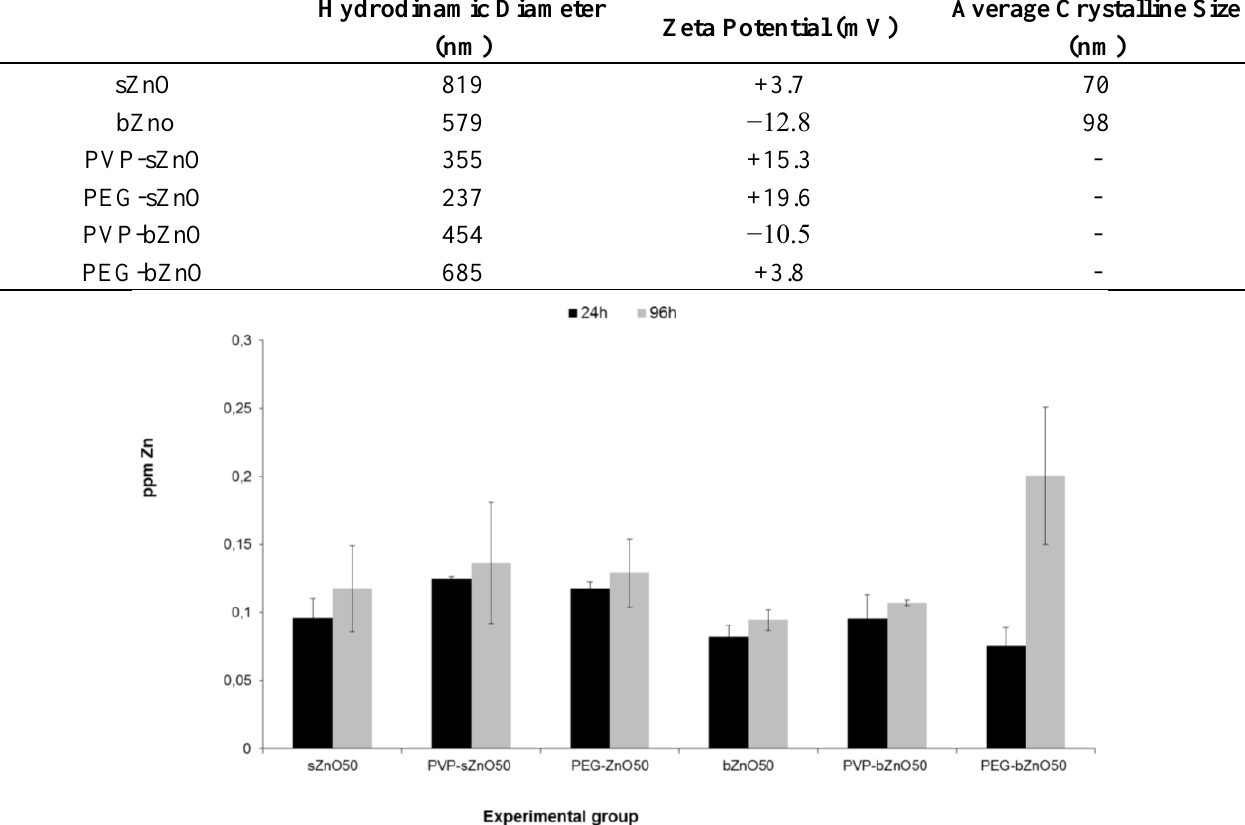
Figure S1. Levels of dissolved ions from sZnO and bZnO after 24 h and 96 h from the beginning of the FETAX assay measured by